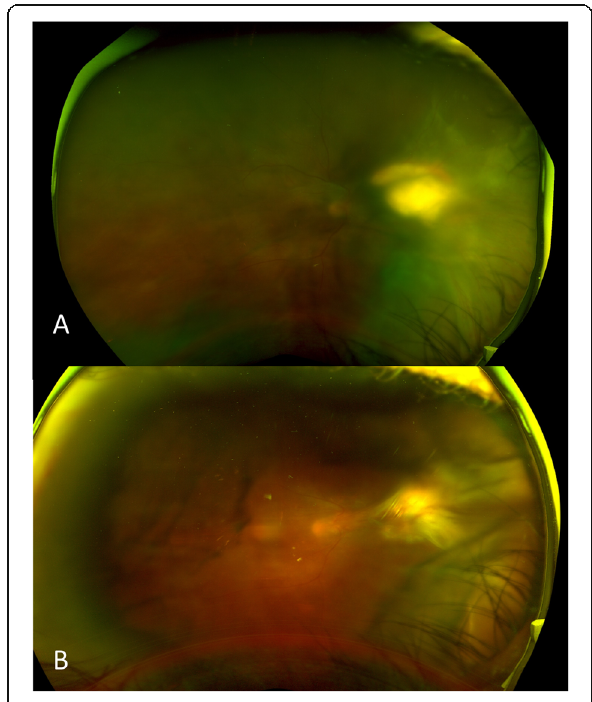
Fig. 3 a Pre-operative after amikacin injections and b post-operative week 2 fundus